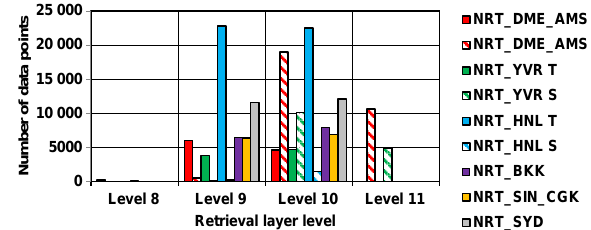
Figure 3. The number of GOSAT/TANSO-FTS TIR CO 2 data points compared to the CONTRAIL CME level flight data for each retrieval grid layer level for each flight. The num- bers of TIR CO 2 data points in the troposphere (“T”) and stratosphere (“S”) are shown separately for the Tokyo–Europe (NRT_DME_AMS), Tokyo–Vancouver (NRT_YVR), and Tokyo– Honolulu (NRT_HNL) flight